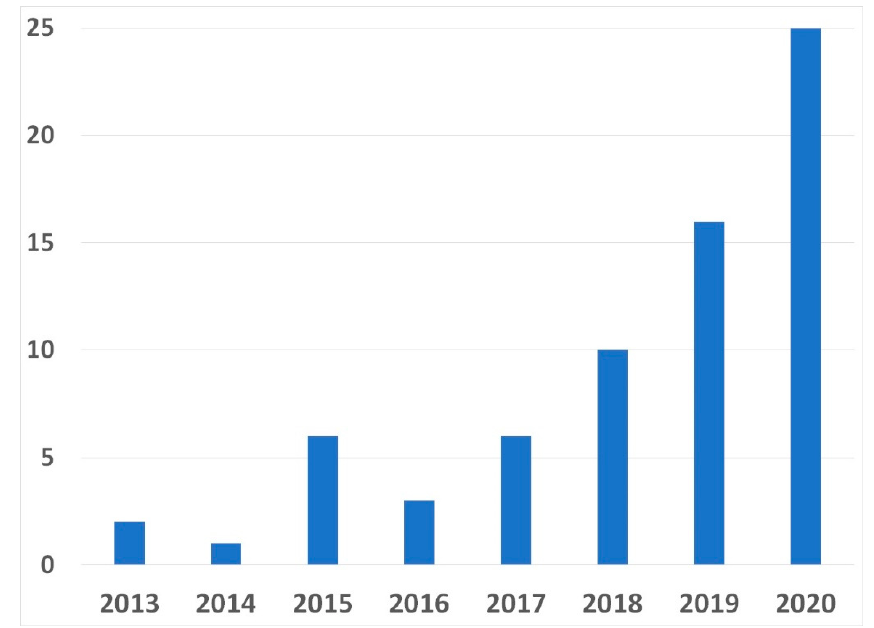
Figure 1. Papers published on high entropy alloys (HEAs) by additive manufacturing (AM) (year 2020 papers published up to April 2020). Table 1. AM systems and technologies (data from [10–12,15,16]) used for HEAs (number of papers).